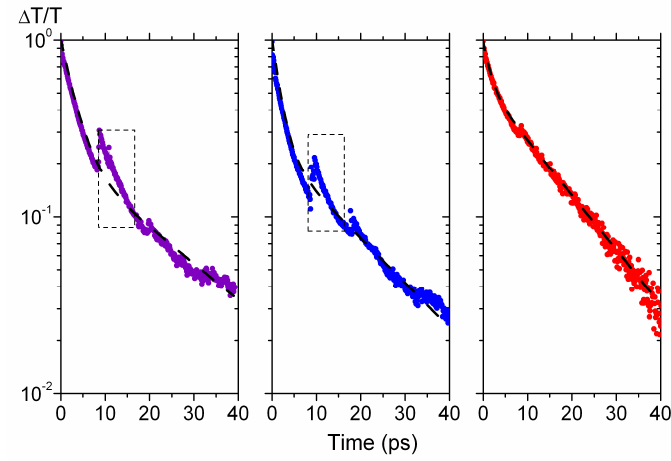
Figure 4. Normalized transmission changes detected for: (left) LT-InGaAs / GaAs(100), (middle) LT-InGaAs / GaAs (111)A, (right) LT-InGaAs / InAlAs / InP (111)A.